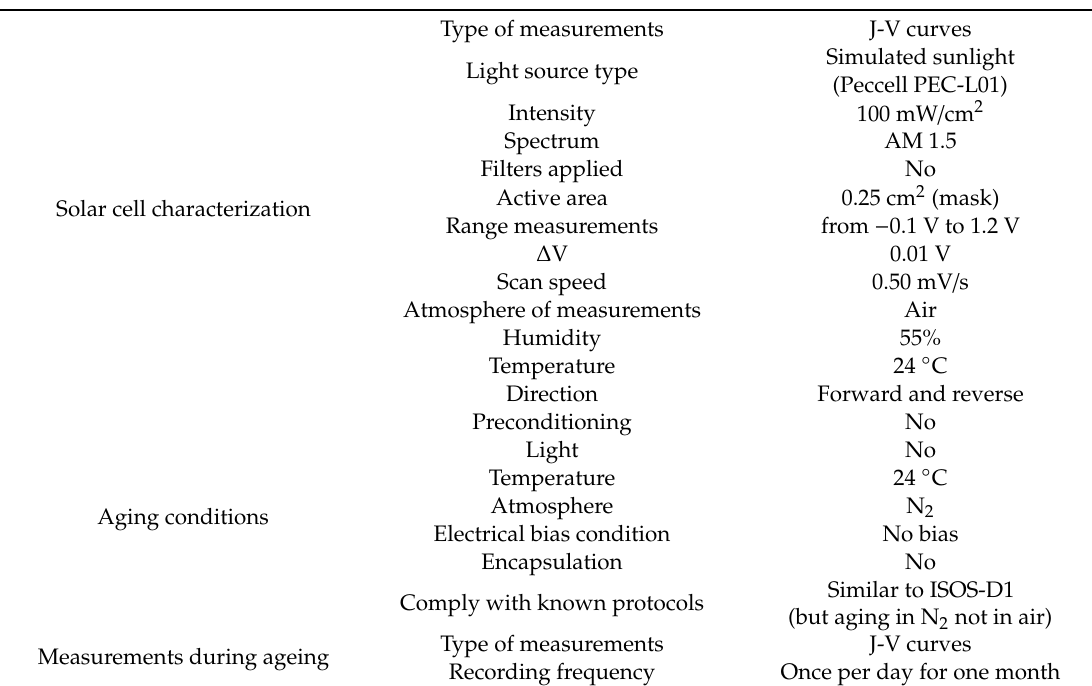
Table 1. Parameters used for solar cell characterization, frequency of analyses and aging conditions (similartoInternationalSummitonOrganicPhotovoltaicStability-darkstoragestudies-level1(ISOS-D-1)